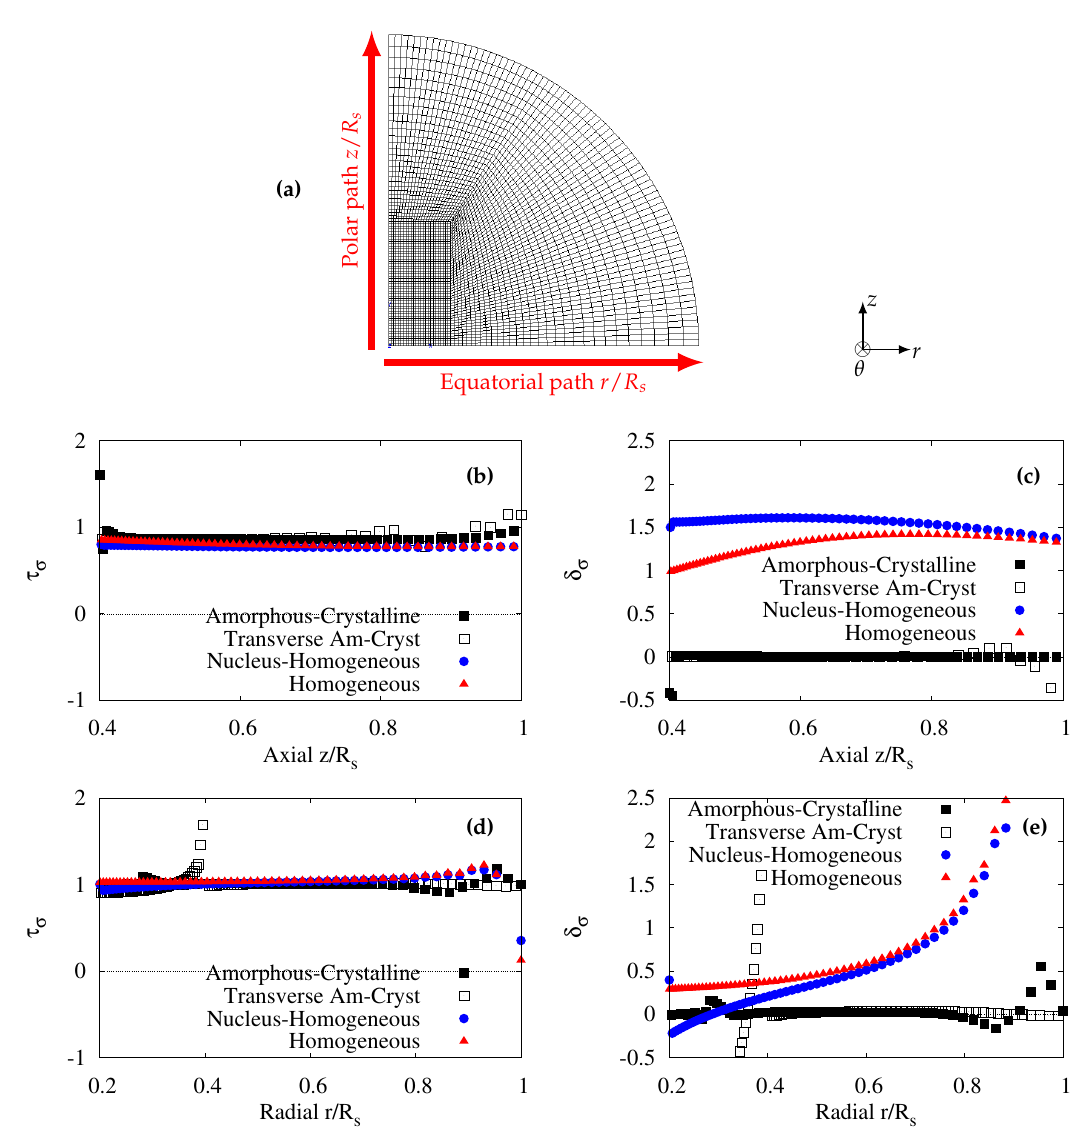
Figure 7. Spherulite under uniaxial tensile strain: ( a ) mesh and coordinates; ( b ) stress triaxiality ratio τ σ along the axial path; ( c ) δ σ parameter along the axial path; ( d ) stress triaxiality ratio τ σ along the radial path; ( e ) δ σ parameter along the radial